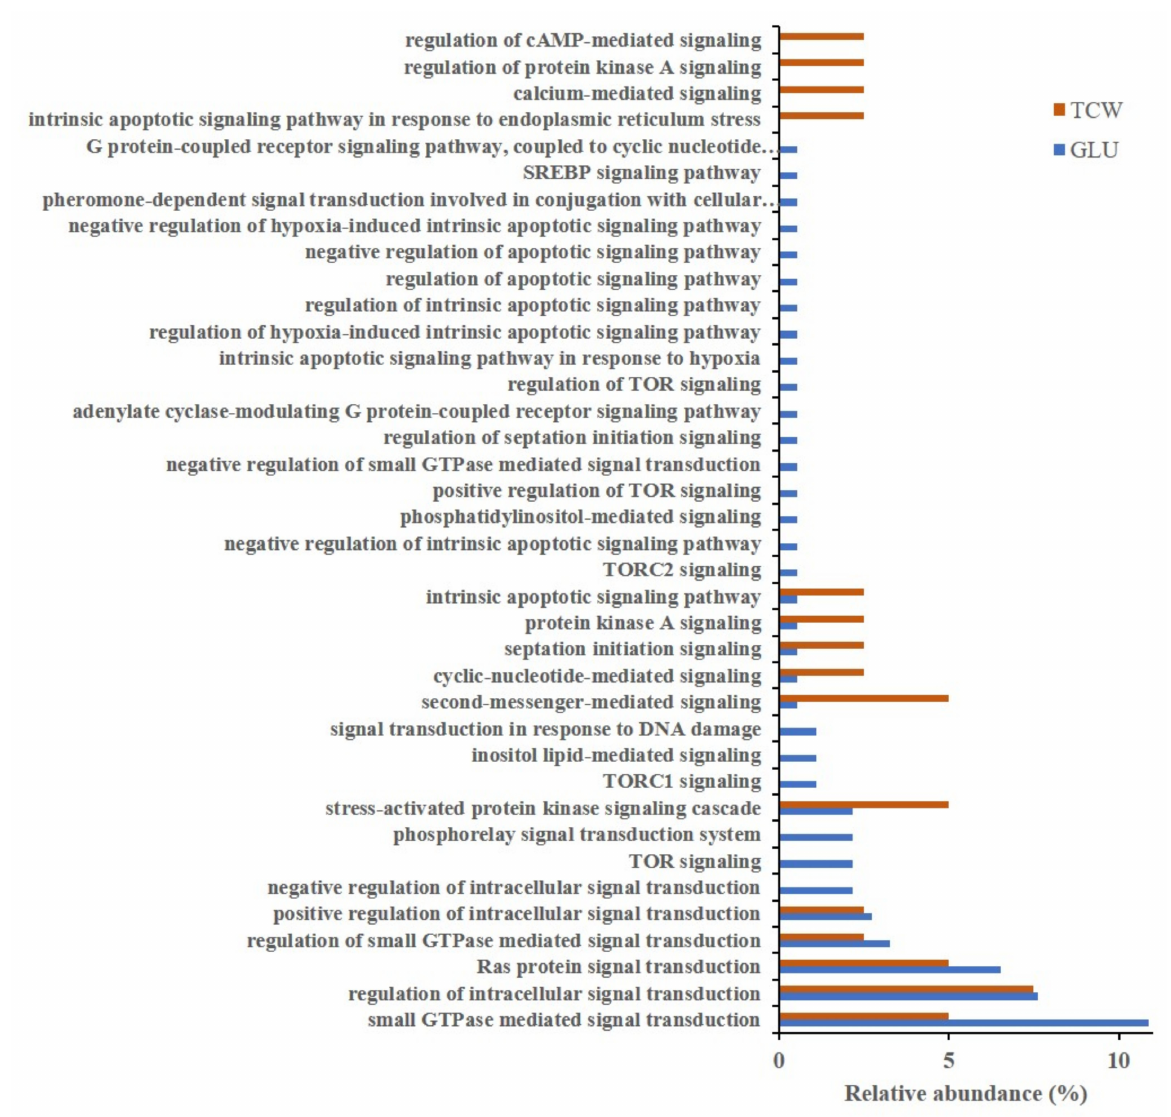
Figure 3. Gene ontology (GO) classification by the biological process of categories related to signaling (level 5 and 6)) of proteins exclusively identified or overexpressed in B. cinerea proteomes (membranome, phosphoproteome, phosphomem- branome, and secretome), under GLU and TCW conditions, as the sole carbon source. Relative abundance represents the percentage of proteins identified in each category relative to the total number of protein GO annotations in this